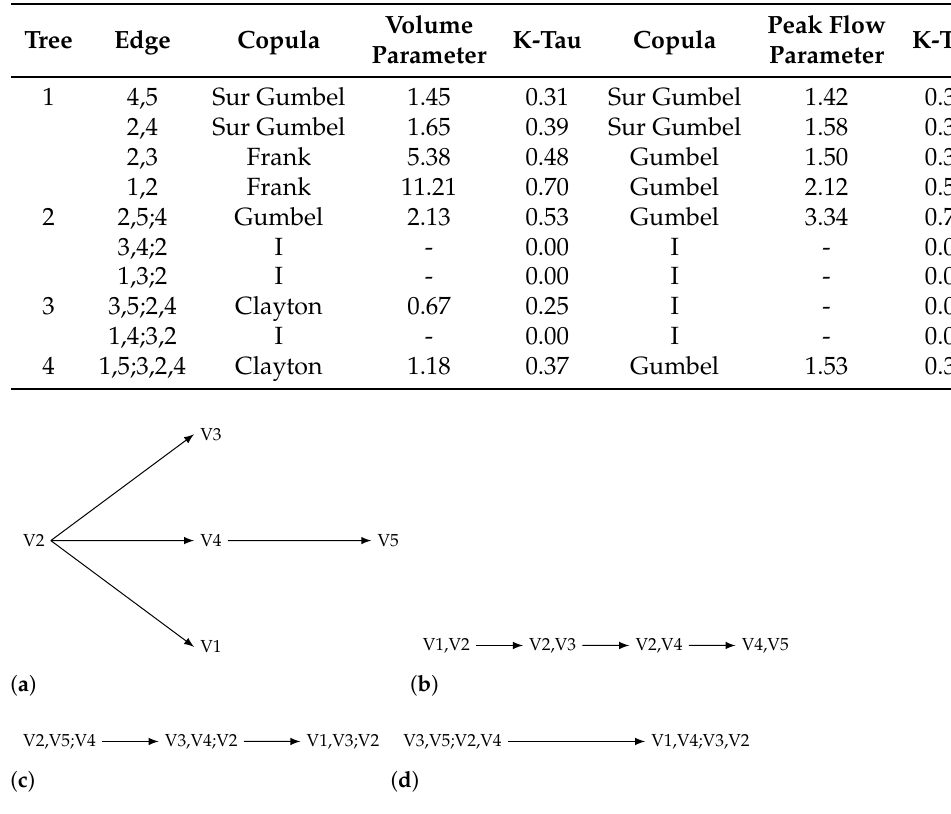
Figure 4. The reduced-network R-vine. V1, V2, V3, V4 and V5 stand for stations 3, 7, 8, 11 and 15, respectively. ( a ) Tree 1. ( b ) Tree 2. ( c ) Tree 3. ( d ) Tree 4.